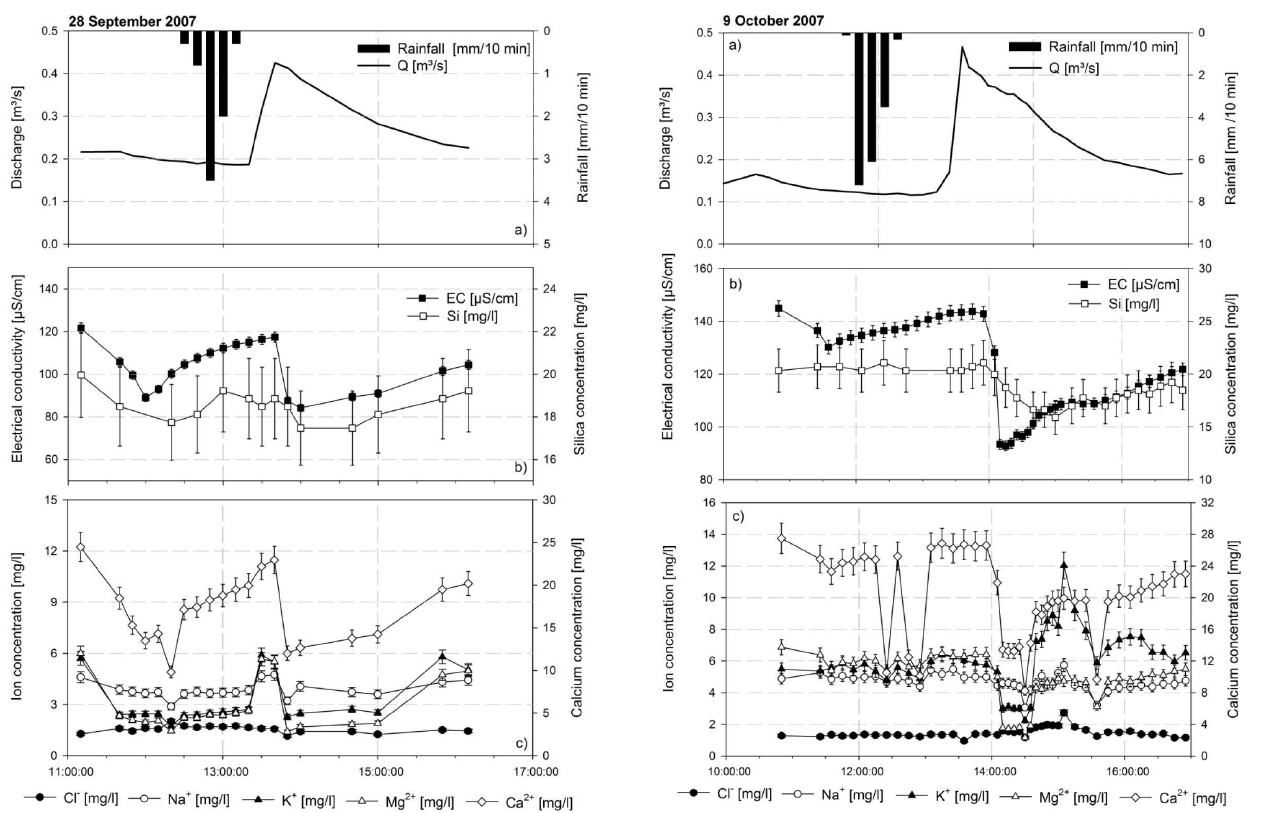
Fig. 4. Event E2 on 9 October 2007: (a) discharge and rainfall, (b) silica and Cl − concentration, and (c) concentrations of Na + , Mg 2 + ,K + , Ca 2 + , and discharge. Error bars indicate measurement uncertainty of 7% for ions and 10% for